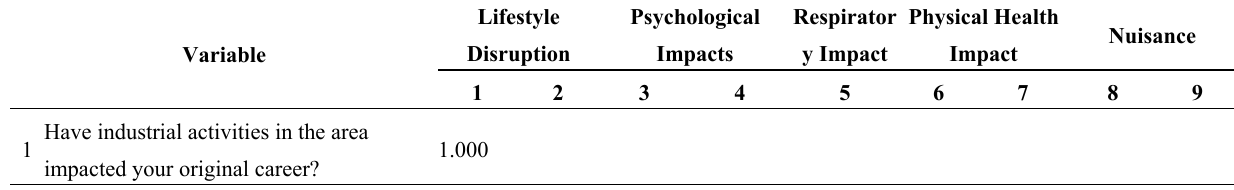
Table 5. Mean scores of risk perception variables and their correlations.